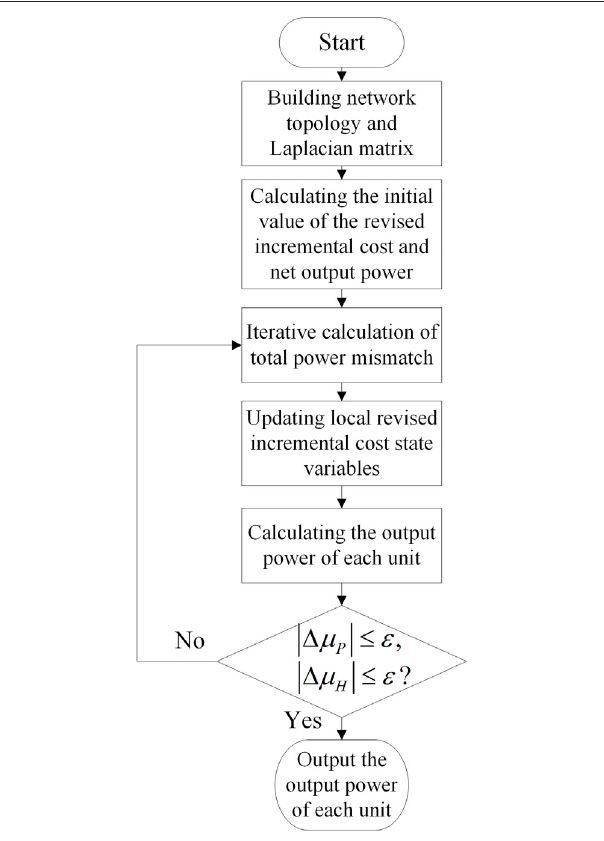
FIGURE 2 | The ED solution process of